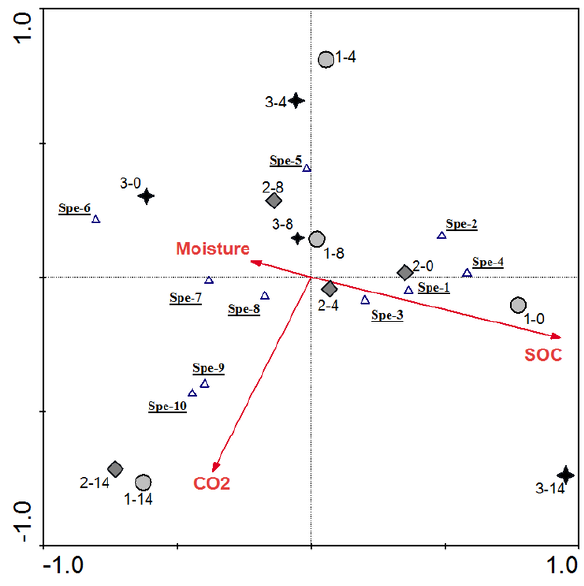
Figure 7: The overall RDA of the correlation between bacterial community structure, the cumulative CO -evolation, and soil 2 properties by Canoco. Symbols of circle, diamond, and star represent samples from the treatments of <0.5mm, 1-2mm, and 2-3mm size aggregates, respectively. Environmental parameters (i.e. cumulative CO -evolation, SOC and moisture) are indicated by 2 triangles or solid lines with filled arrows. Species parameters are shown using the symbols of triangle,and each species indicated by a underlined